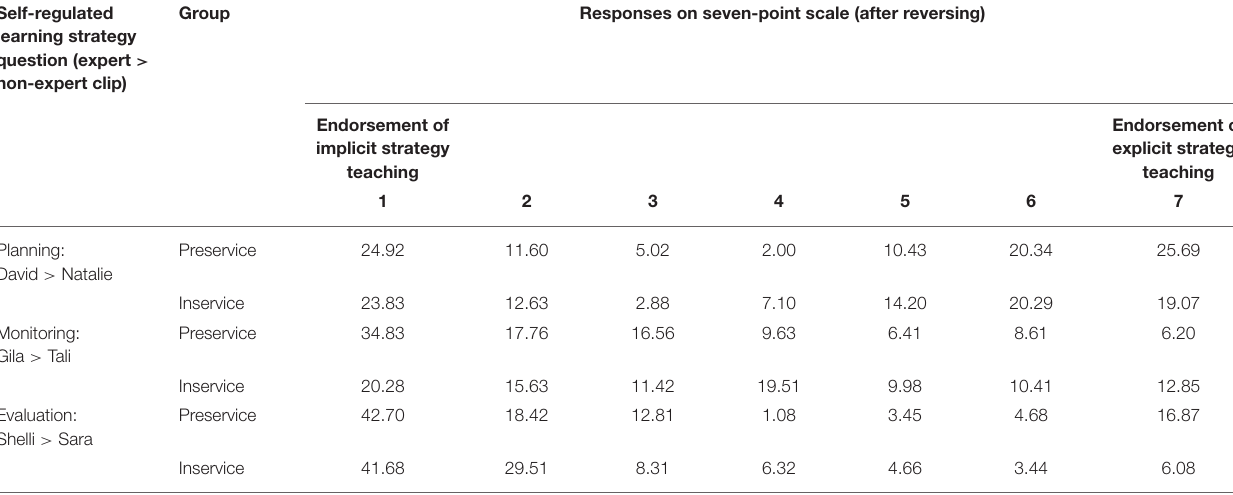
TABLE 2 | Teachers’ distribution of observer instrument responses (in percentages) by group. Self-regulated Group learning strategy question (expert > non-expert clip)